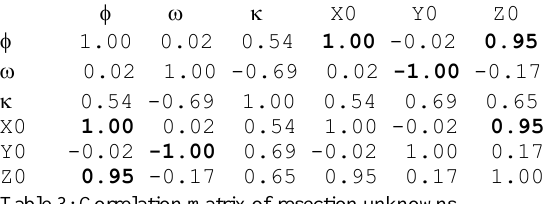
Table 3: Correlation matrix of resection unknowns